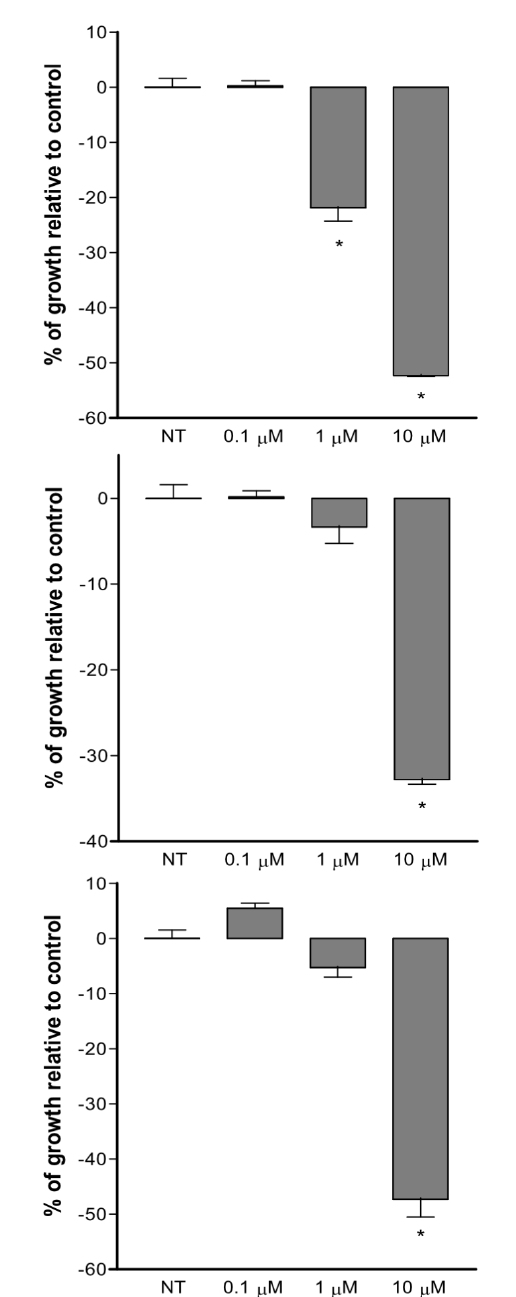
matography followed by HPLC on a Nucleodur 100-5 C 18 (Phenomenex) (5 μ m; 7.8 mm i.d. × 250 mm) with MeOH/H 2 O (9:1) as an eluent (flow rate 0.9 mL/min) to give theonellapep- tolide Id ( 1 ) (68.5 mg), sulfinyltheonellapeptolide ( 2 , 4.6 mg) and theonellapeptolide If ( 3 , 2.1